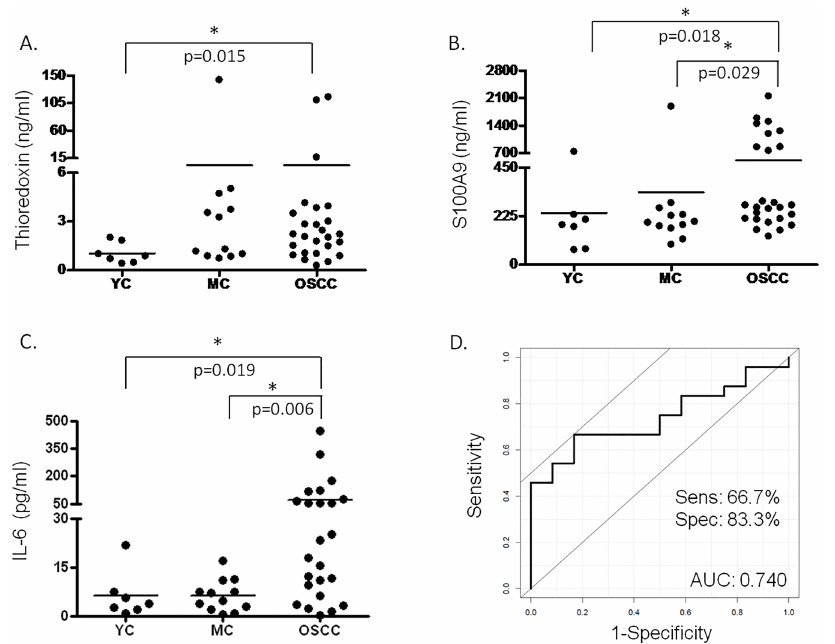
Fig 5. Salivary protein levels determined with ELISA. The salivary concentration of (A) thioredoxin,(B) S100A9protein and (C) IL-6 is indicatedin case of younghealthy controls (YC), age matched controls (MC) and OSCC group. In cases where significantdifference was observed the p value is indicated. (D) ROC analysisof the combinedeffect of IL-6 and